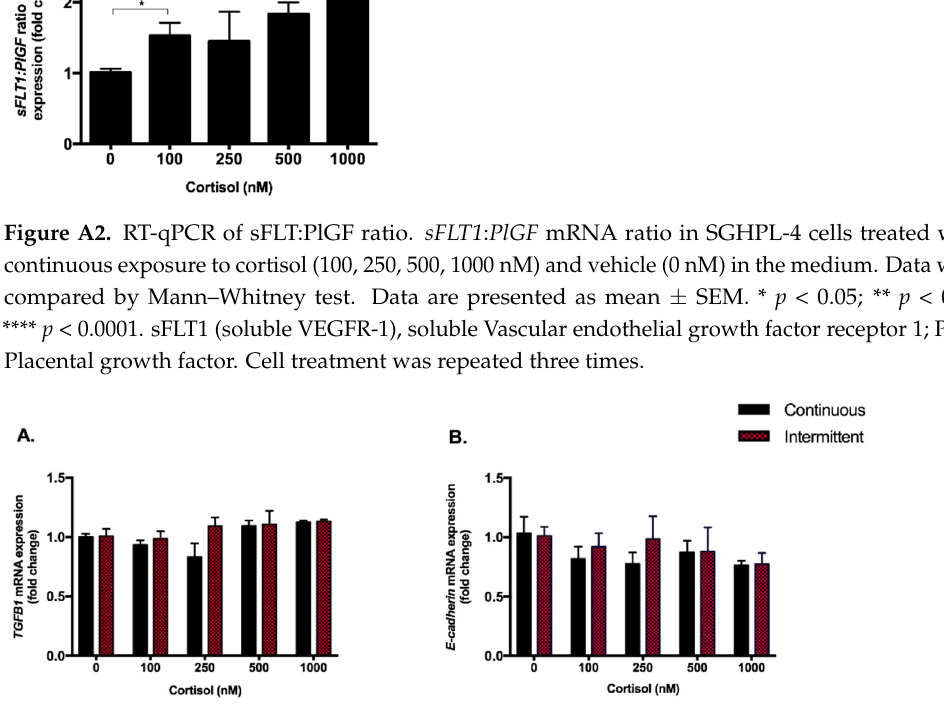
Figure A3. RT-qPCR. TGFB1 ( A ) and E-cadherin ( B ) mRNA in SGHPL-4 cells treated with continuous or intermittent exposure to cortisol (100, 250, 500, 1000 nM), and vehicle (0 nM) in the medium. Data were compared by two-way ANOVA with Tukey multiple comparisons test. Data are presented as mean ± SEM. TGFB1, Transforming growth factor β 1. Cell treatment was repeated three times.